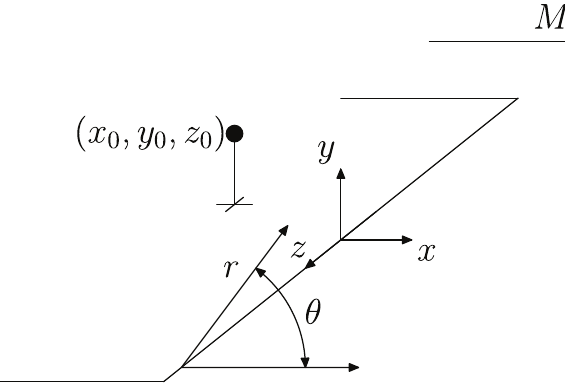
Figure 1. Notation for semi-in fi nite plate